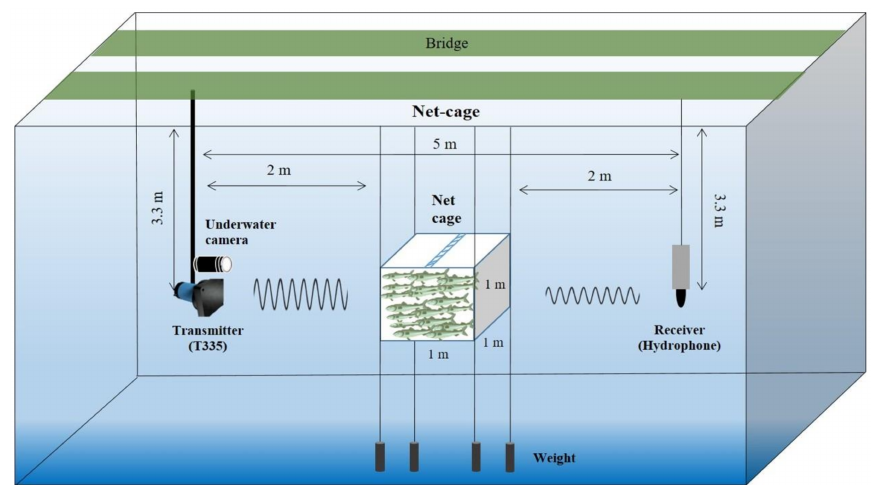
Figure 1. Schematic of the experimental system used to measure sound attenuation from the fish schools (Japanese horse mackerel) at mid-frequency bands. Transmitter, receiver, net cage, and underwater camera were set at a depth of 3.3 m below the sea surface.